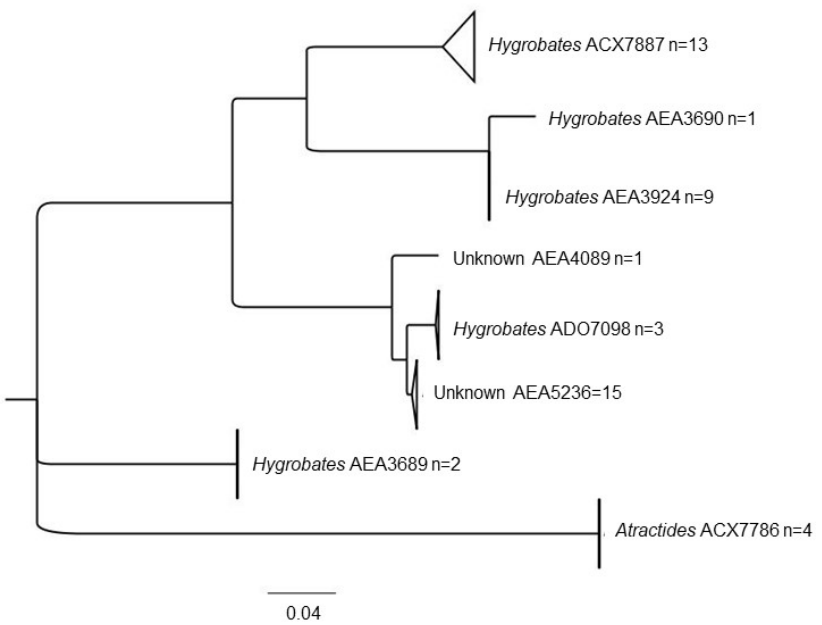
Figure 7. NJ tree for Hygrobatidae family.